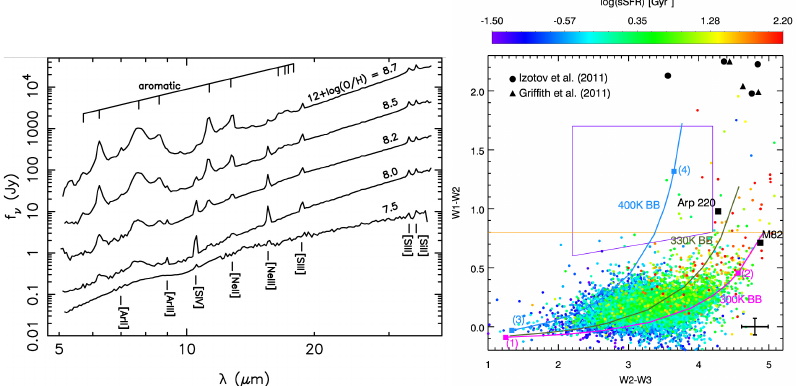
Figure 8. Here, we highlight some issues with mid-IR AGN selection in dwarf galaxies. Left: Average mid-IR spectra of starburst galaxies, without AGN, binned by metallicity as labeled, adapted from Engelbracht et al. [112]. Right: The WISE colors of dwarf galaxies color-coded by sSFR. The model tracks represent an elliptical template+a hot dust blackbody component of the indicated temperature. Note the bulk of the dwarf galaxies with red W1-W2 colors are consistent with intense starbursts. The few more robust candidates for AGN powered systems all lie within the purple polygon which represents the Jarrett et al. [116] AGN selection, adapted from Hainline et al. [115], AAS © . Reproduced with